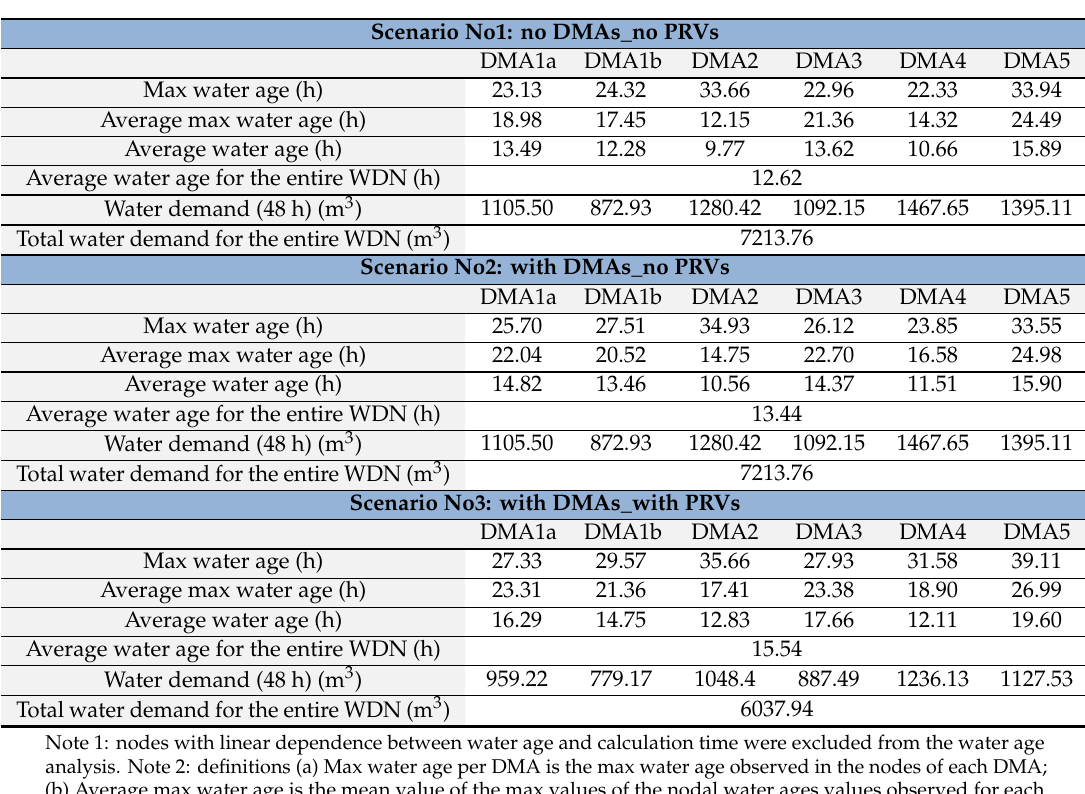
Table 4. Water age and water demand values per DMA and for the entire water distribution network (WDN) for each one of the three scenarios studied.